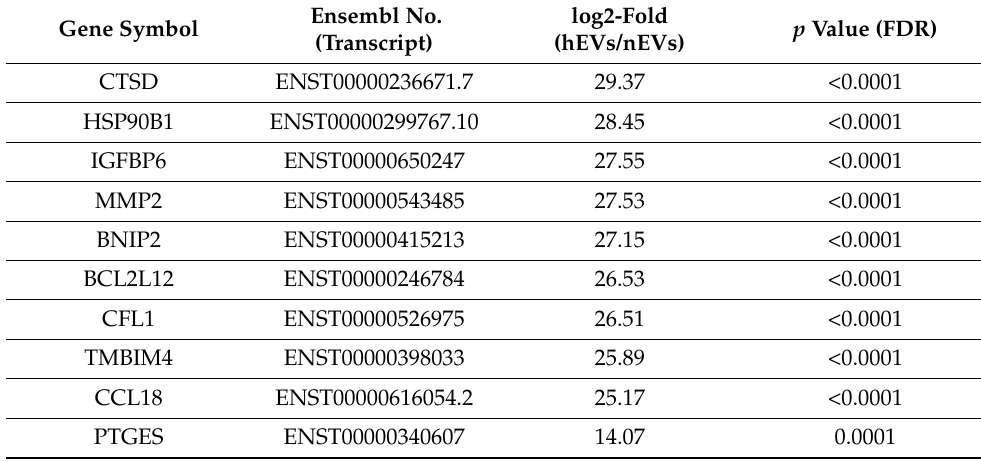
Table 1. Transcriptomics analysis. Selected statistically significant increased and decreased transcripts (FDR < 0.05).